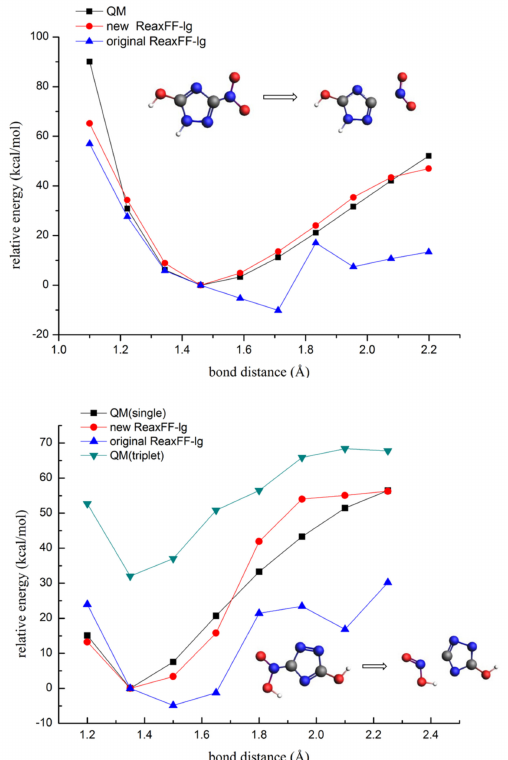
Figure 4. The dissociation energies of the C-N single bond during NO 2 and HONO elimination (gray—carbon atom; white—hydrogen atom; red—oxygen atom; blue—nitrogen